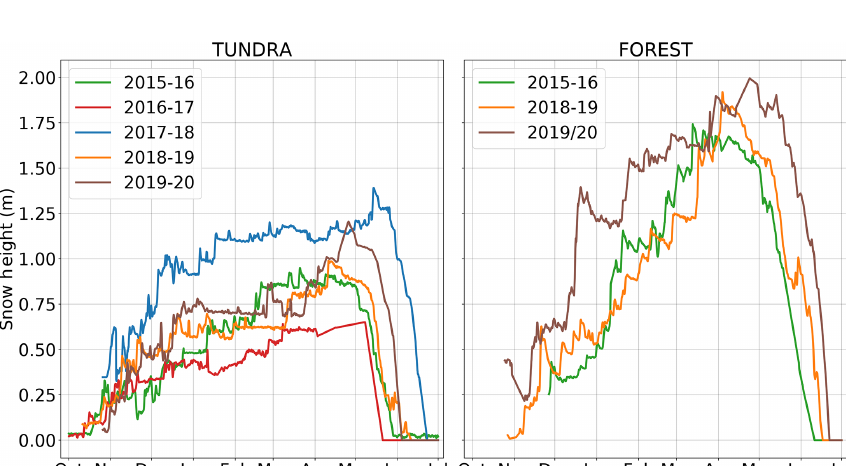
Figure 3. Cumulative snowfall for three winters at TUNDRA.